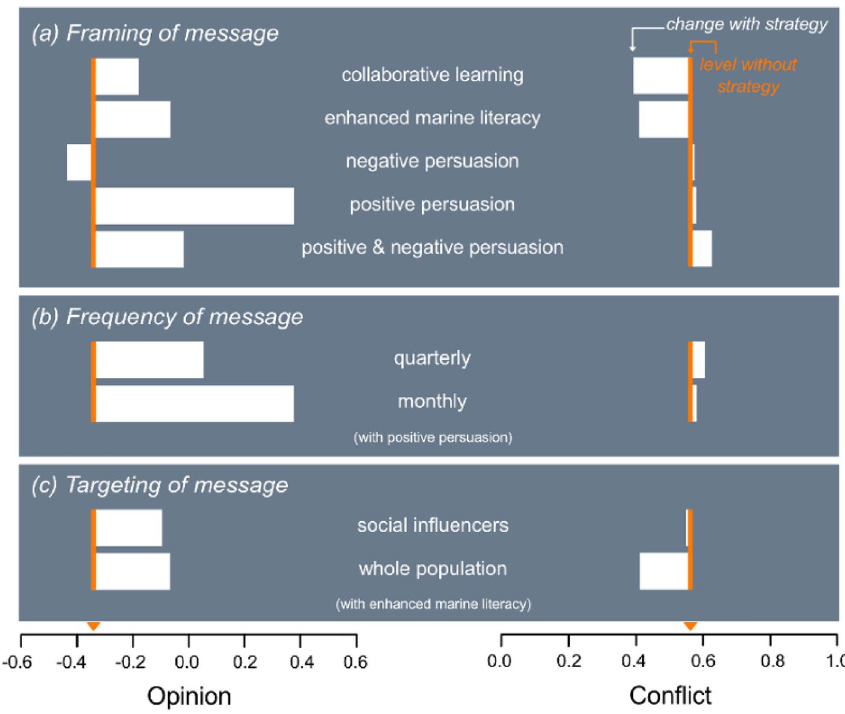
Figure 3. Movement of average opinion and conflict in response to a range of communication strategies applied from 2021. The orange line indicates baseline values for opinion and conflict when no strategy was applied (case shown in Fig. 2). Examples of time-series plots for collaborative learning and positive persuasion are shown in Fig.